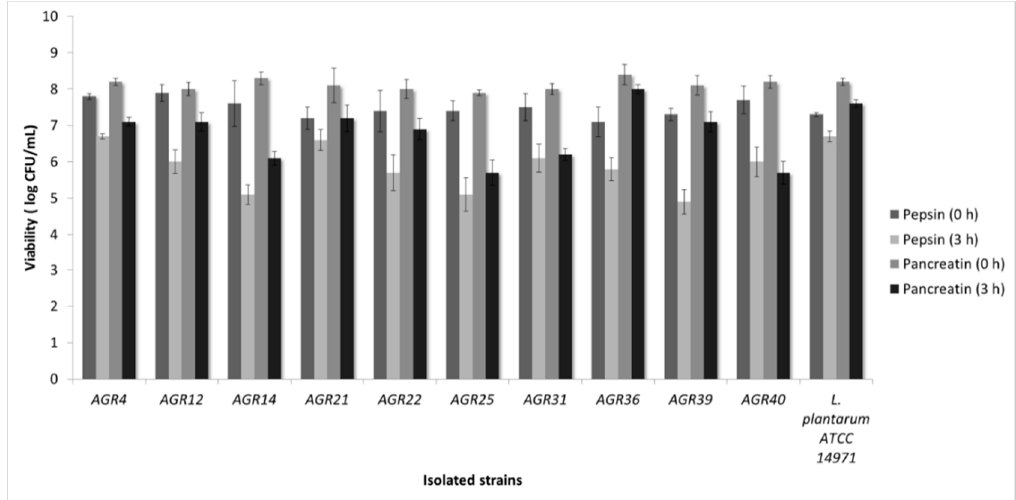
Figure 3. Assessment of strain viability after exposure to pepsin and pancreatin for 0 to 3 h.